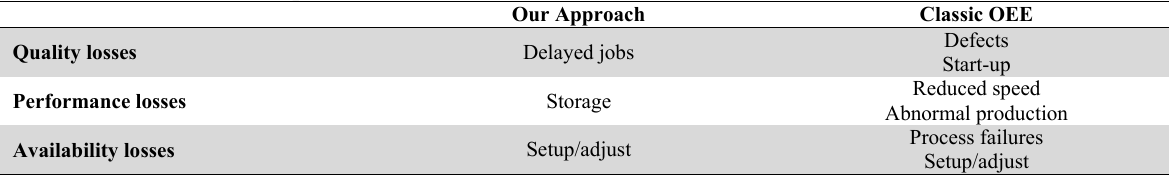
Definition of OEE variables